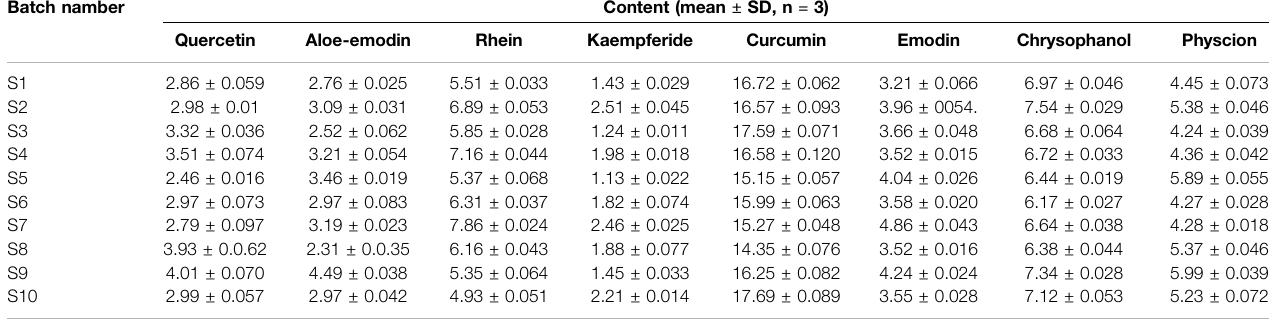
TABLE 4 | Content (mg/g) of the eight compounds in ten batches freeze-dried powder samples of GDD. Batch namber